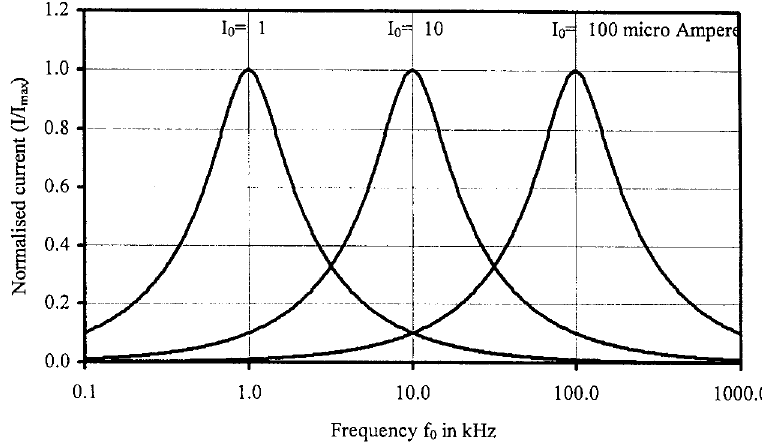
FIGURE 3 Simulated response of a FIS-based resonator for different I